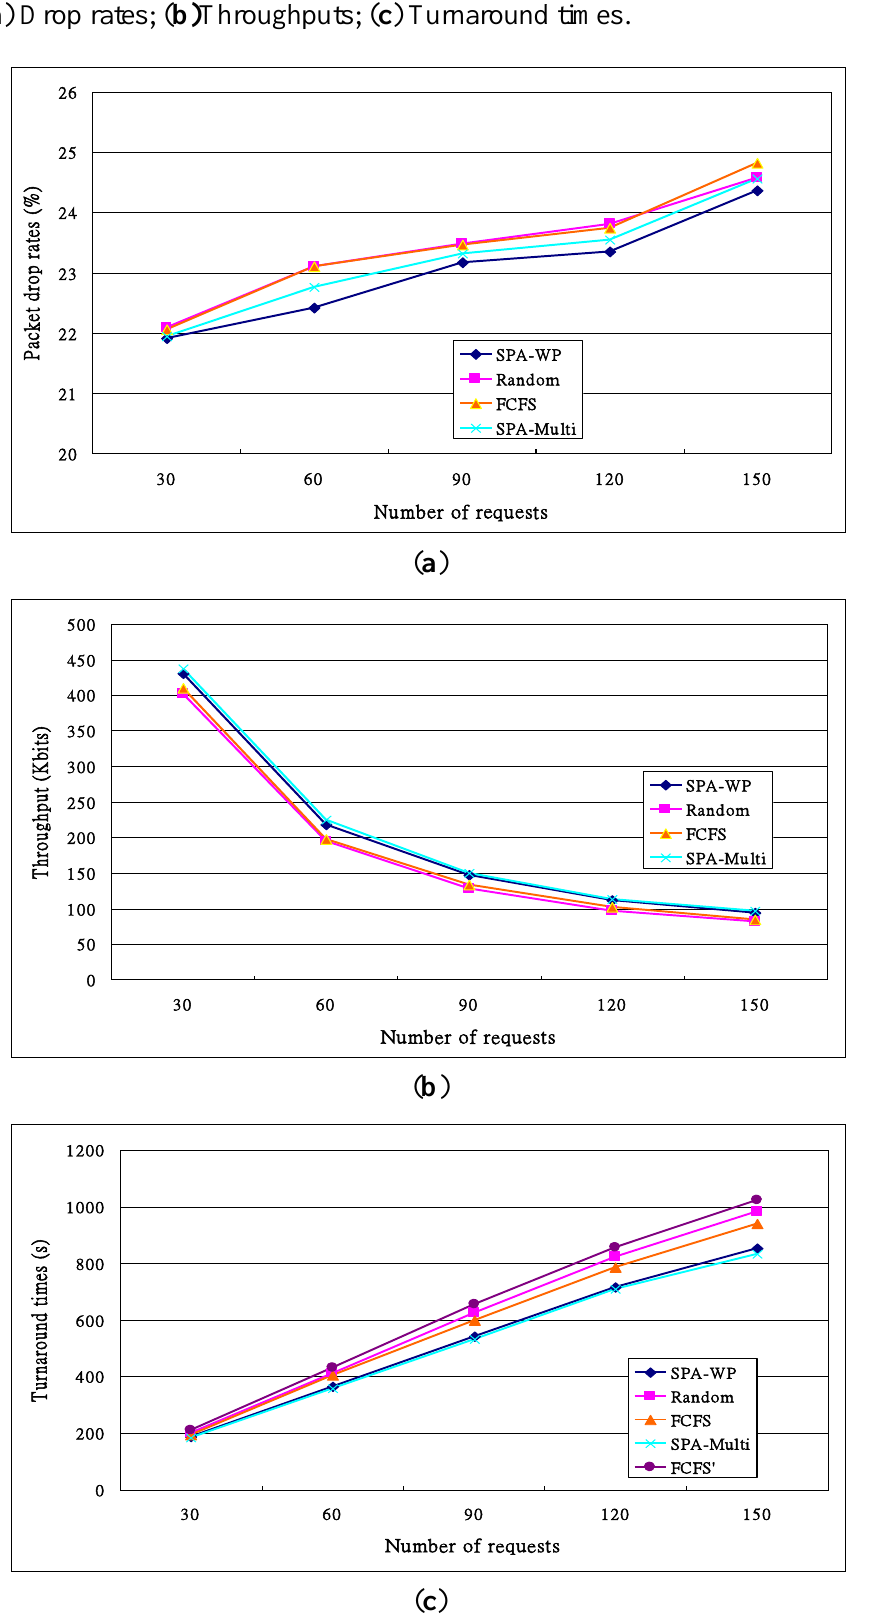
Figure 13. Performance of the fourth experiment given different numbers of requests per second. ( a ) Drop rates; ( b) Throughputs; ( c ) Turnaround